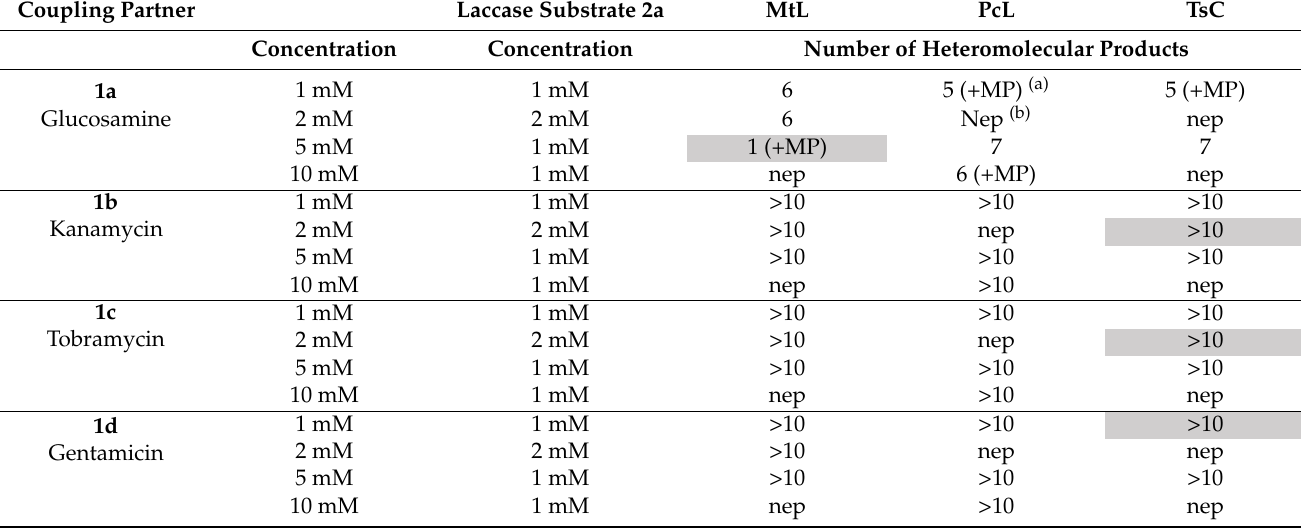
Table 1. Glucosamine and aminoglycosides ( 1a – 1d ) used in laccase-catalyzed reactions as coupling partners, 2,5-dihydroxy- N -(2-hydroxyethyl)-benzamide ( 2a ) used as laccase substrate and the number of synthesized heteromolecular